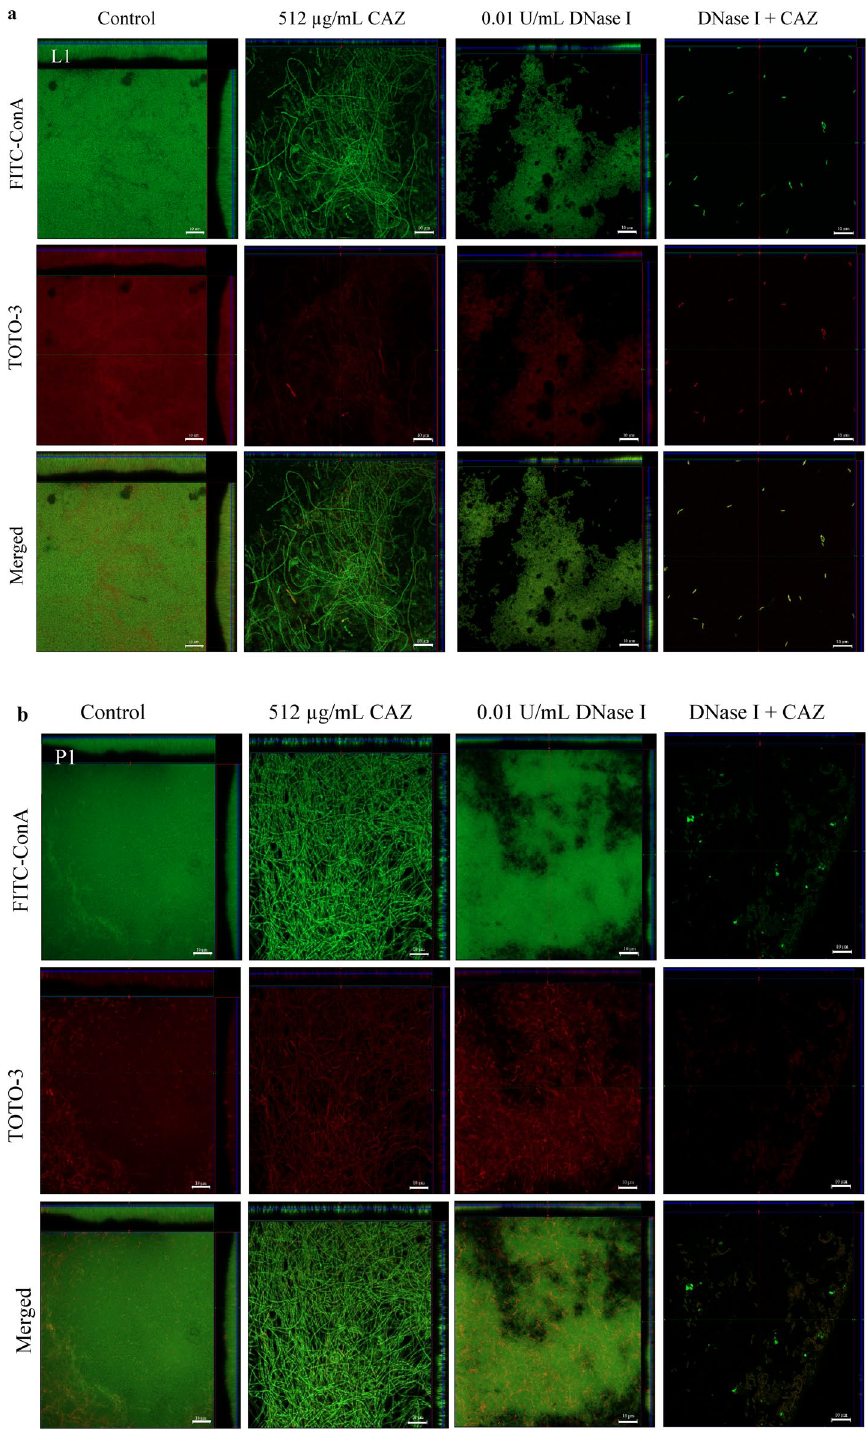
Figure 3. DNase I combined with CAZ eradicated B. pseudomallei L1, P1 and H777 biofilms. CLSM images of B. pseudomallei L1 ( a ), P1 ( b ) and H777 ( c ) biofilm biomass and eDNA grown on glass coverslips untreated (control) or treated with either 0.01 U/ml DNase I, or 512 µg/mL ceftazidime (CAZ), or DNase I + CAZ. The 2-day biofilms were then stained with FITC-ConA (biofilm biomass, green) and TOTO-3 (eDNA, red). The images are representative of three independent experiments and were taken using a Zeiss 800 CLSM microscope (63 × magnification). The scale bar represents 10